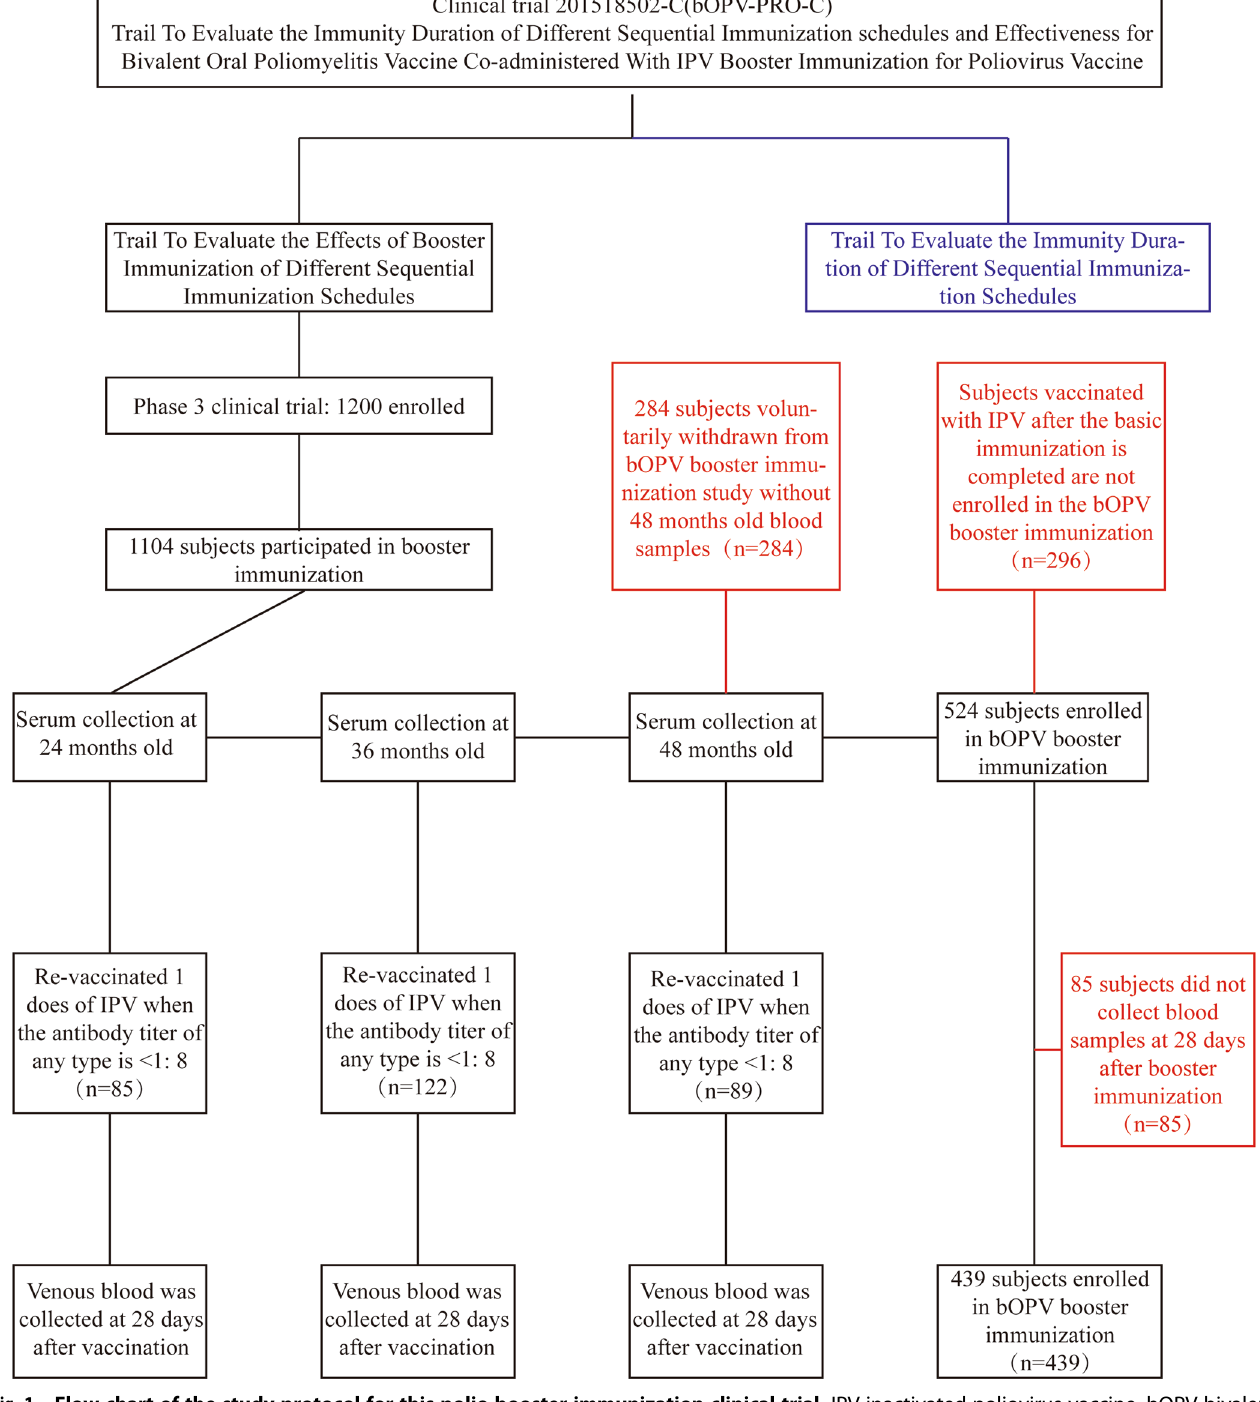
Fig. 1 Flow chart of the study protocol for this polio booster immunization clinical trial. IPV inactivated poliovirus vaccine, bOPV bivalent oral poliovirus vaccine. Blue box: immunopersistence study, which is not within the scope of the present analysis; red boxes: descriptions of the situations of those who did not participate in this booster immunization clinical